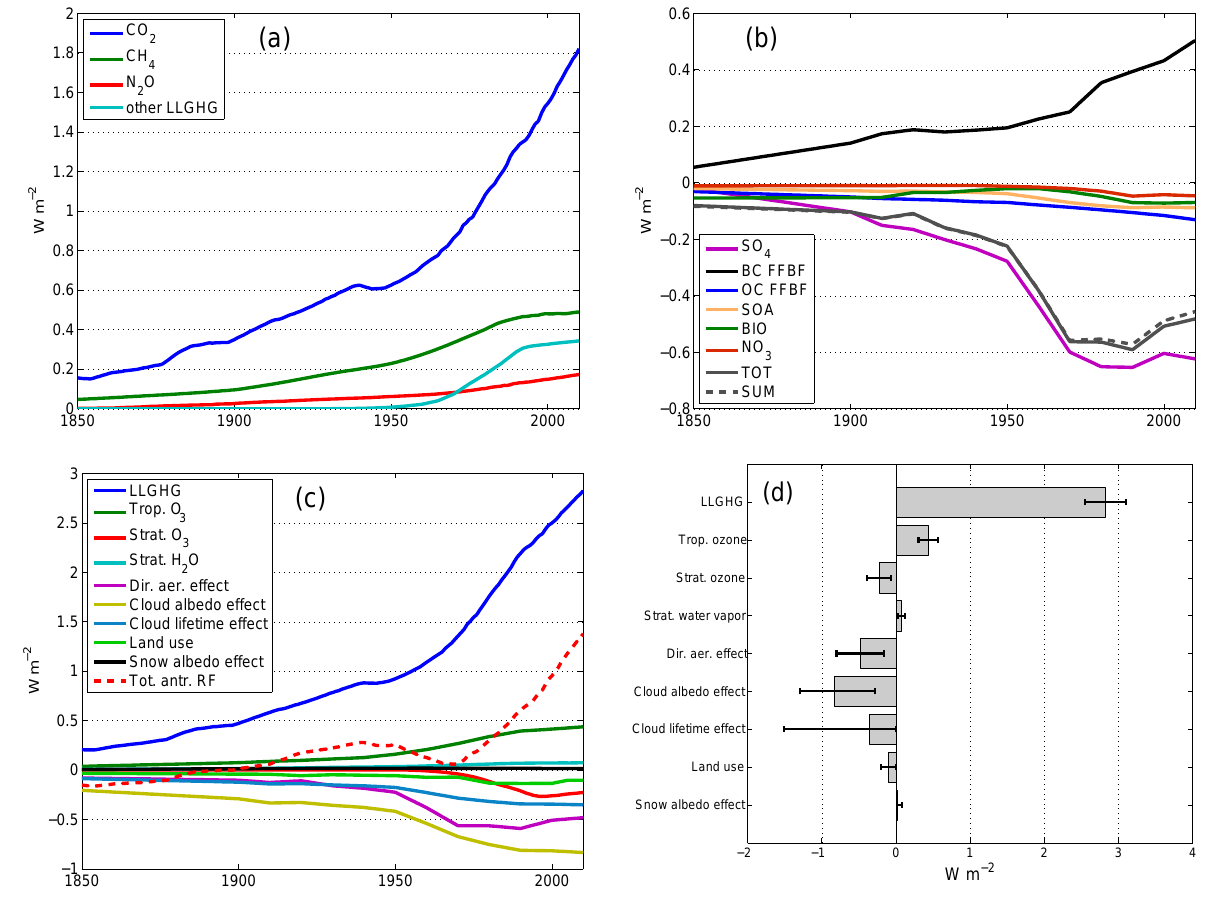
Fig. 1. Time series of radiative forcing from 1850 until 2010 for the LLGHGs (a) , the direct aerosol effect (b) , all anthropogenic forcing mechanisms (c) and RF in 2010 for all components (d) . The error bars represent the 90% confidence interval.